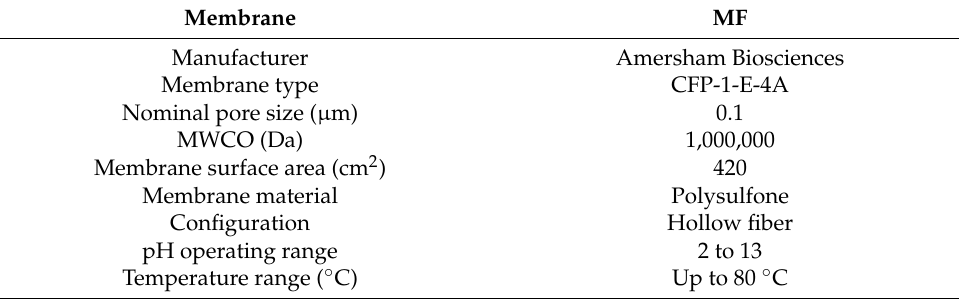
Table 1. Operating specifications of the microfiltration